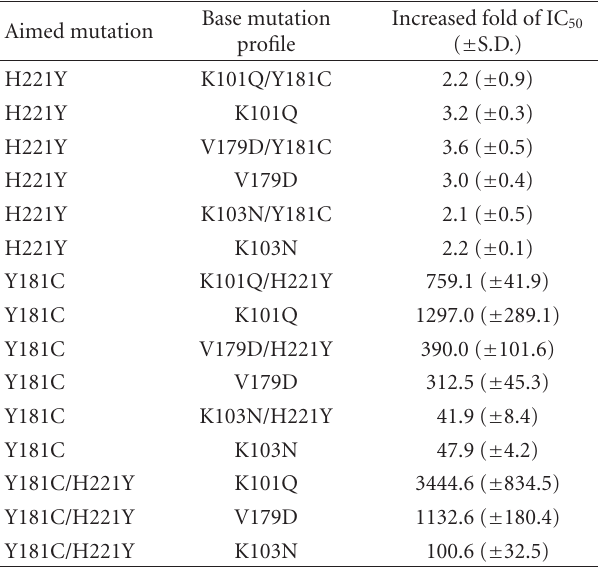
Table 2: Contribution of H221Y, Y181C, H221Y/Y181C to an increased NVP resistance based on various mutation